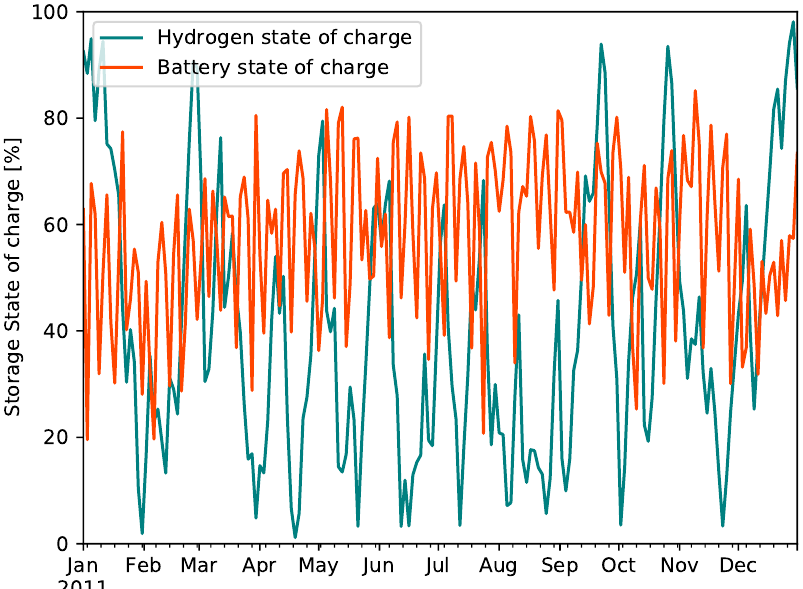
Figure 6. Annual trend of storage unit state of charge by technology. The blue line shows the state of charge of the hydrogen storage, the red line illustrates battery storage units which have been accumulated for better visualisation. Values have been clustered to an average of 48 hours per